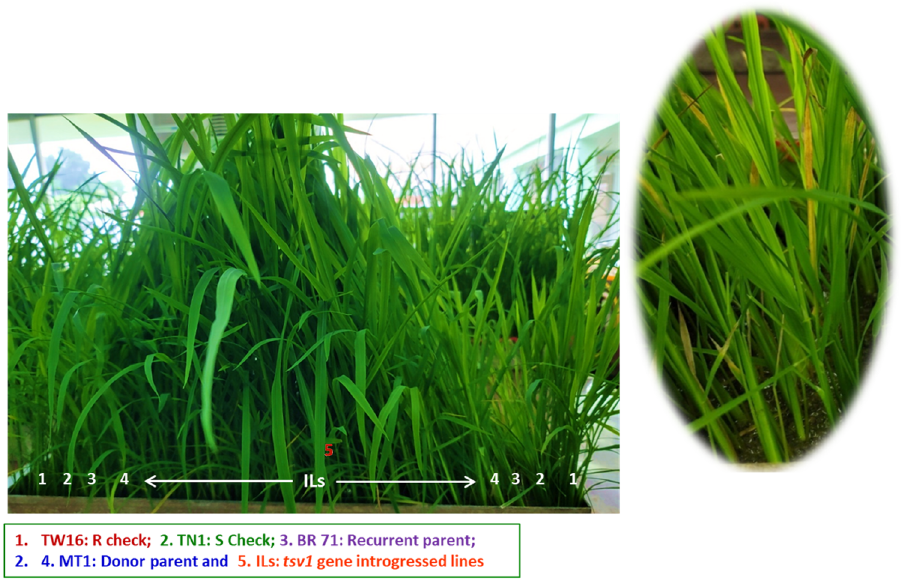
Figure 4. Plants are exhibiting symptoms of RT disease after inoculation. ILs are exhibiting resistant reaction against RT disease.